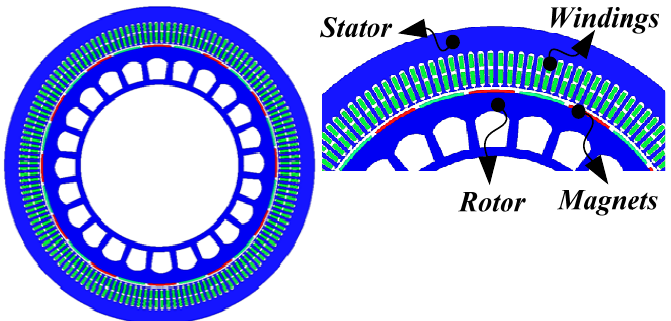
Figure 1. The structural diagram of a 6*3-phase PMSM.